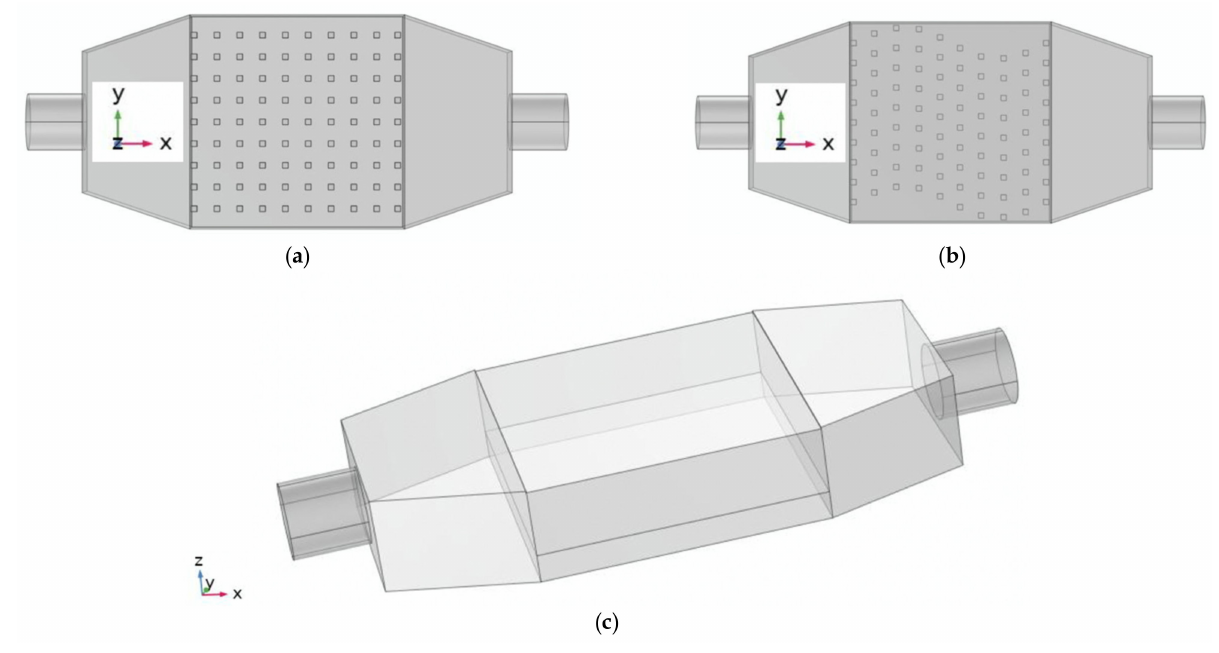
Figure 1. Three different configurations (( a ) Straight pin-fins configuration, ( b ) Wavy pin-fins config- uration, ( c ) No pin-fins